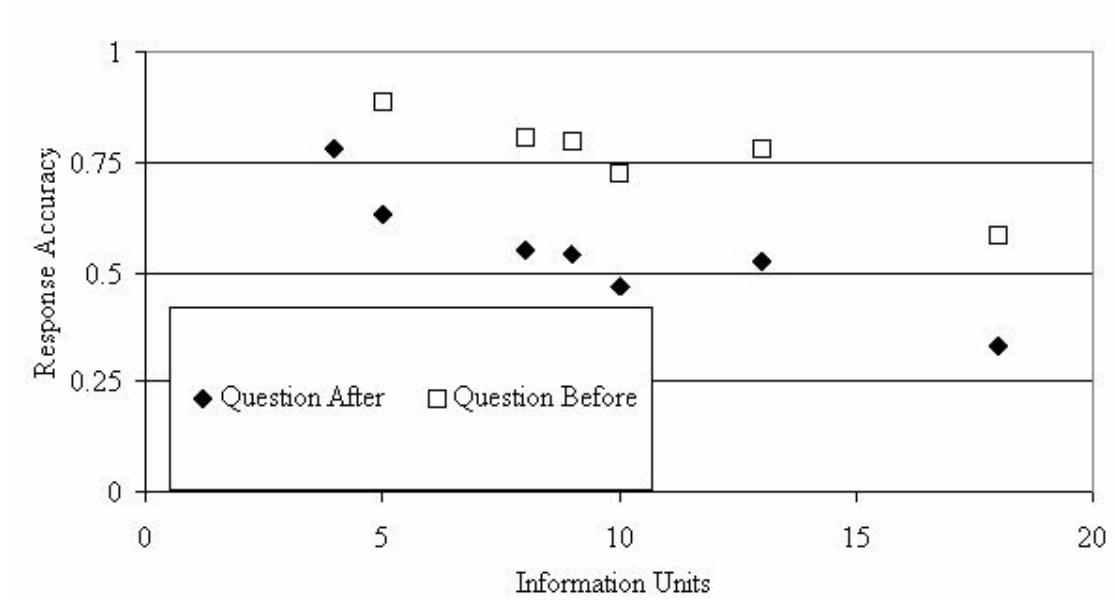
Figure 7. Response Accuracy vs Information